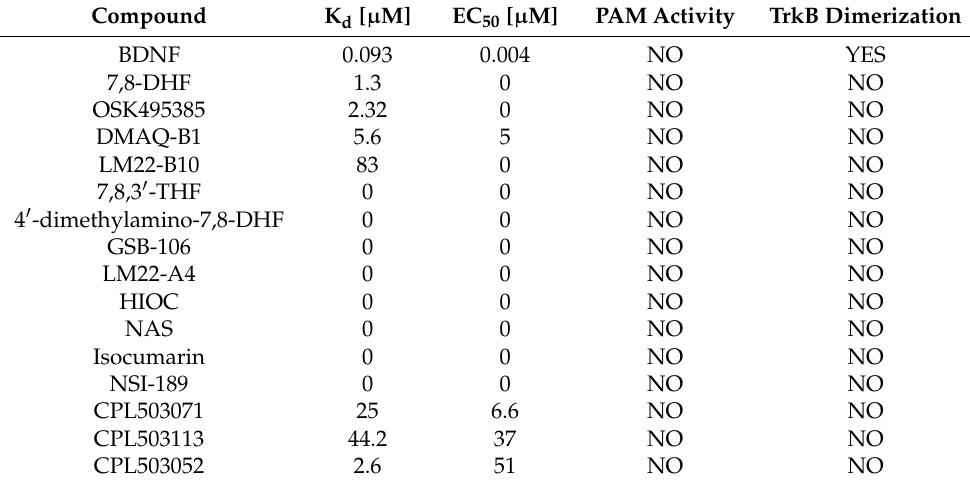
Figure 4. Evaluation of ligand-induced TrkB dimerization by native electrophoresis. The exTrkB receptor was incubated with tested compounds (stoichiometry ratio, 1:1). Dimerization of exTrkB was monitored by sample separation in non-reducing conditions. The upper band (red arrow) corresponds to exTrkB dimers induced by ligand binding; the lower band (blue arrow) corresponds to exTrkB monomers. Table 1. Summary of results obtained for compounds described in the literature as TrkB agonists and molecules identified as TrkB orthosteric agonists during the screening